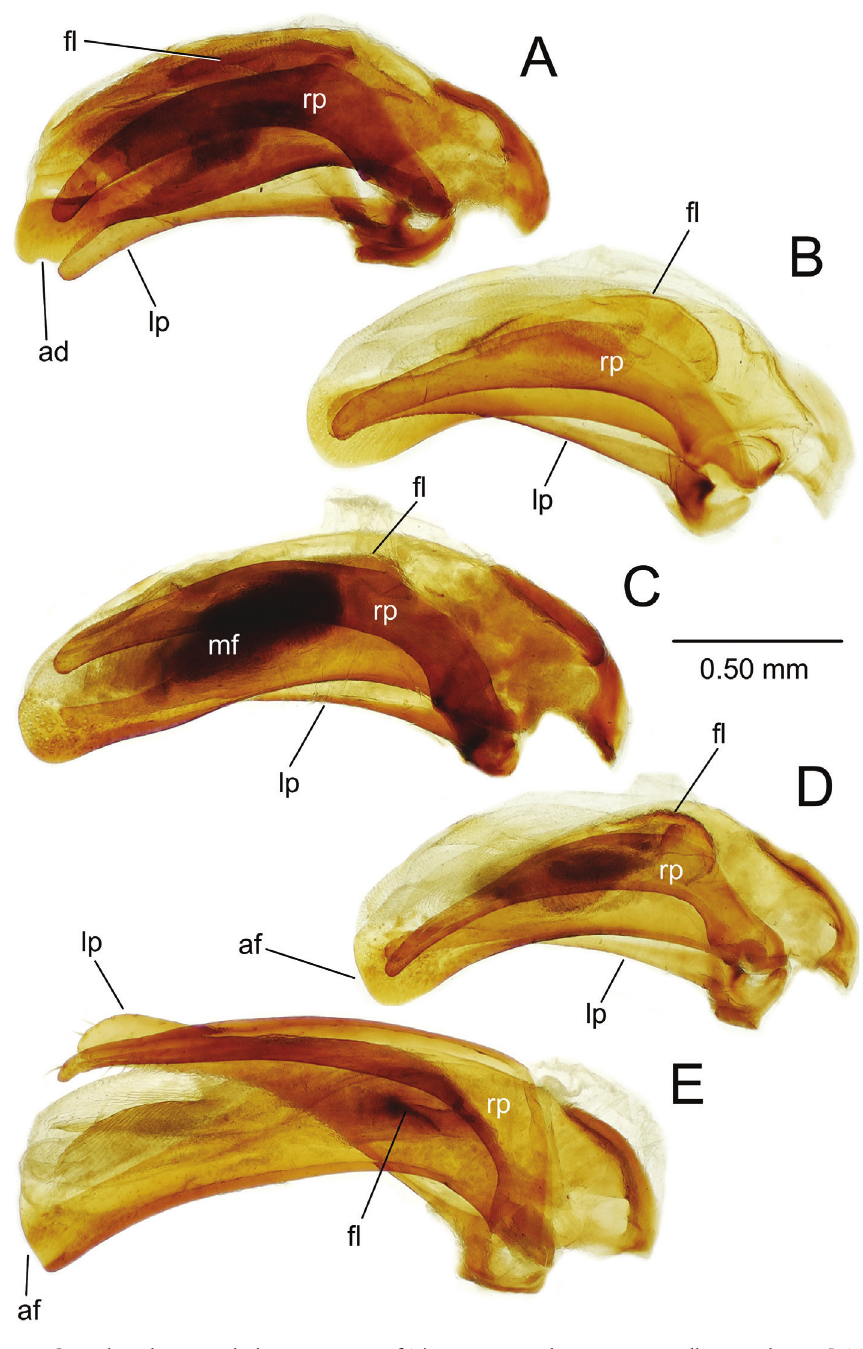
Figure 3. Male aedeagus including parameres of Theprisa spp., right, or anatomically ventral view A T. ot- way B T. convexa C T. montana D T. australis E T. darlingtoni. Abbreviations: ad, apical divot; af, apical face; fl, flagellum; lp, left paramere; mf, microtrichial field; rp, right